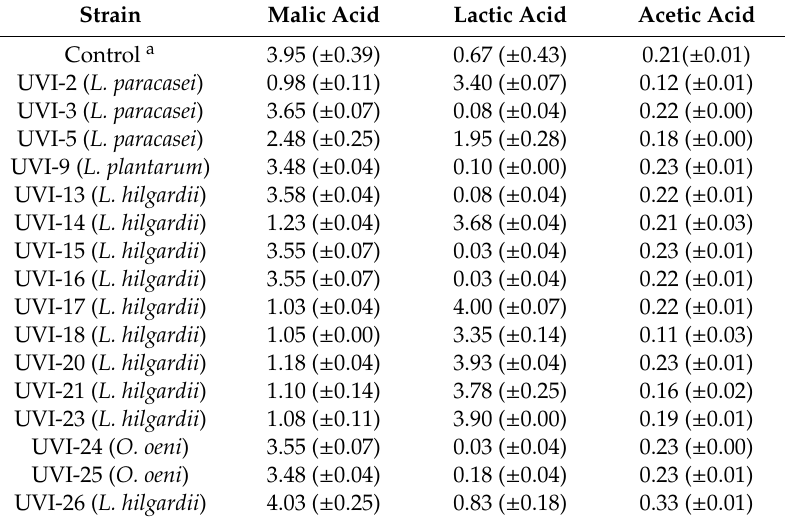
Table 2. Microvinifications with sixteen LAB strains: malic acid consumption and lactic and acetic acid production.